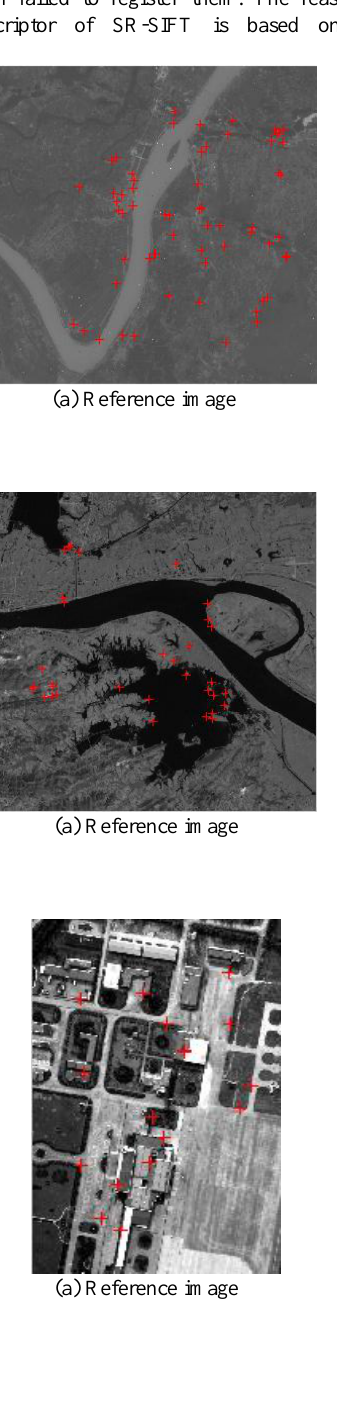
Table 2. The comparison of registration accuracy of different methods